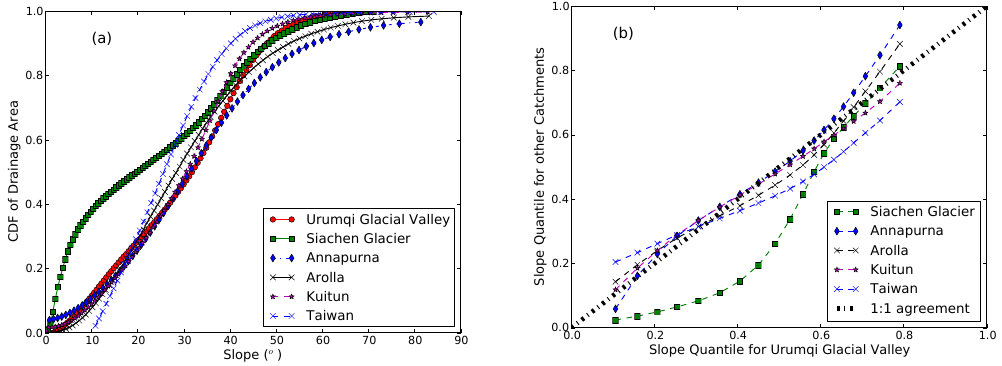
Fig. 14. (a) Cumulative distribution functions of slopes in the Arolla, Annapurna, Kuitun, Siachen and Urumqi catchments. (b) Quantile- Quantile plots of slope distribution in the Arolla, Annapurna, Kuitun and Siachen catchments compared to the Urumqi Glacial Valley catchment. Data derived from SRTM V4. and ASTER V2 DEMS. Tests where perfomed to ensure that the difference in grid spacing did not significantly bias the results. ASTER GDEM is a product of METI and